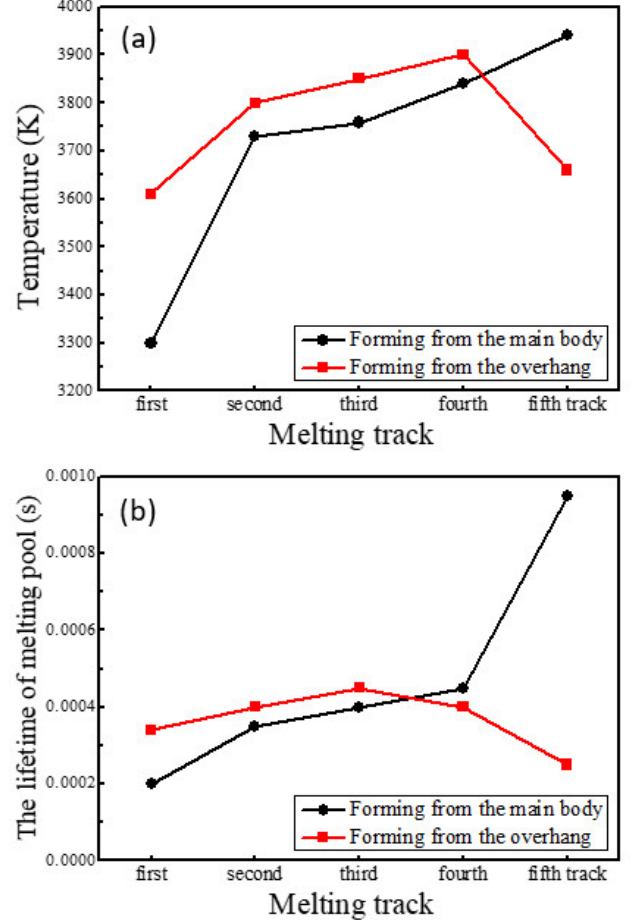
Figure 5. ( a ) The maximum temperatures at the midpoints of the five tracks. ( b ) The lifetime of the melting pool at the midpoints of the five tracks.